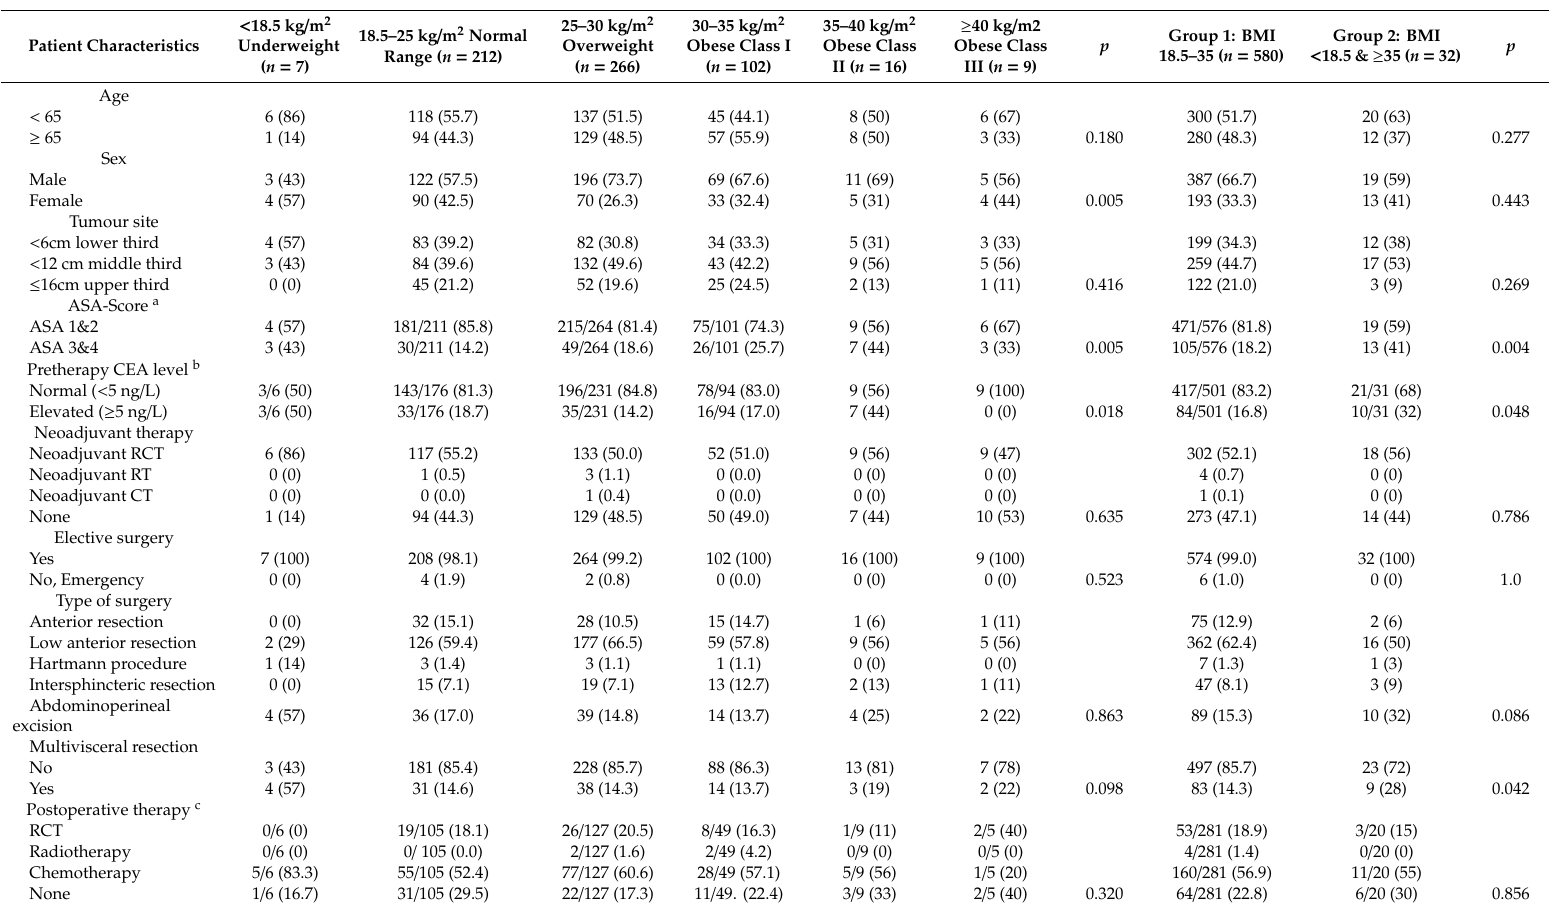
Table 2. Demographics, tumour and treatment characteristics of 612 patients for